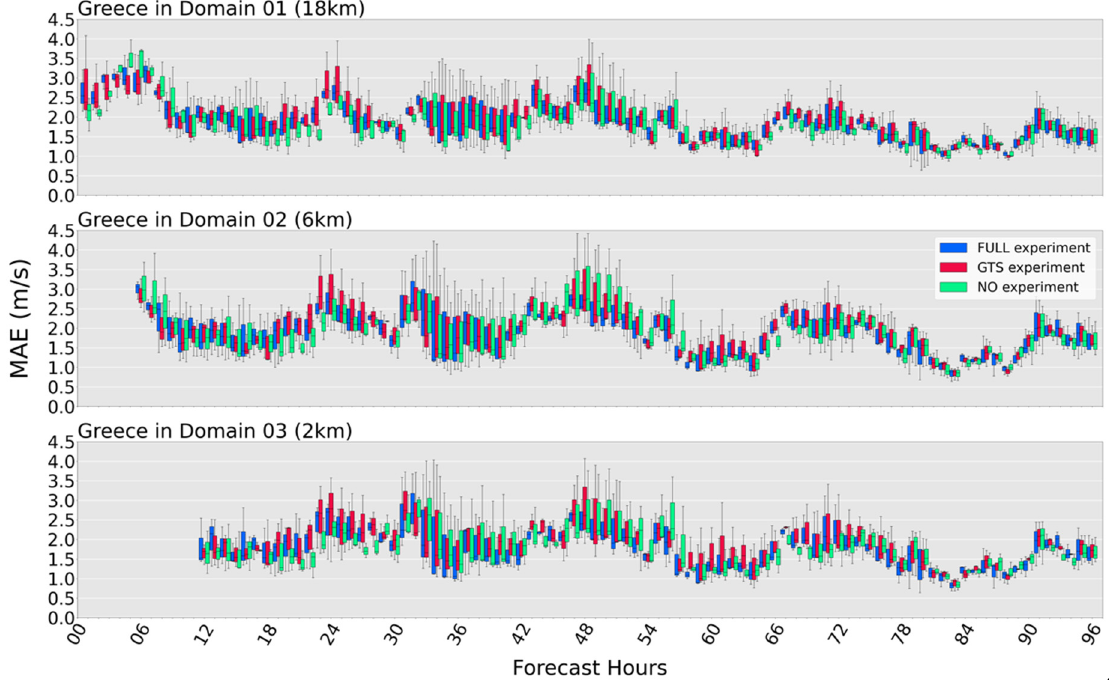
Figure 8. Hourly time series of 10 m wind speed MAE for the area of Greece. Each panel refers to a specific spatial resolution domain and the scores achieved for each type of experiment (i.e., FULL, GTS, NO). In blue are the boxplots for the FULL experiment; the GTS experiment is depicted in red and the NO experiment is depicted in green.